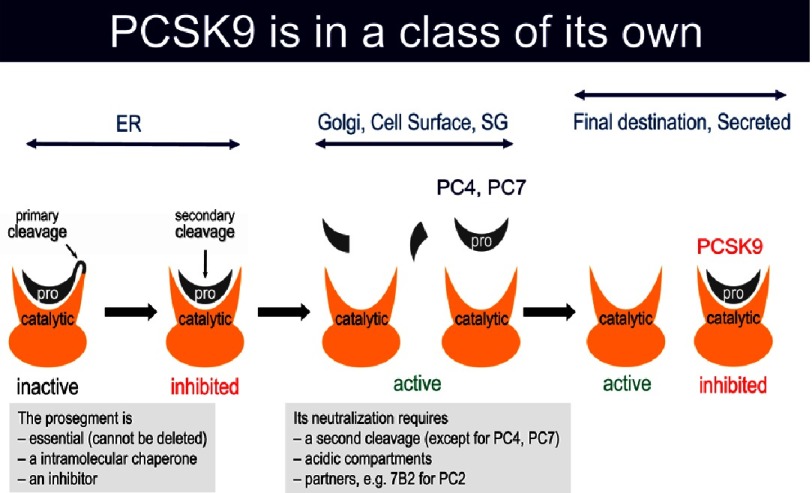
Zymogen activation of the proprotein convertases.The various strategies used by the convertases to get activated. It all starts in the ER where the first autocatalytic cleavage occurs. Except for PCSK9 all the other convertases get rid of their inhibitory prodomain to become enzymatically active.